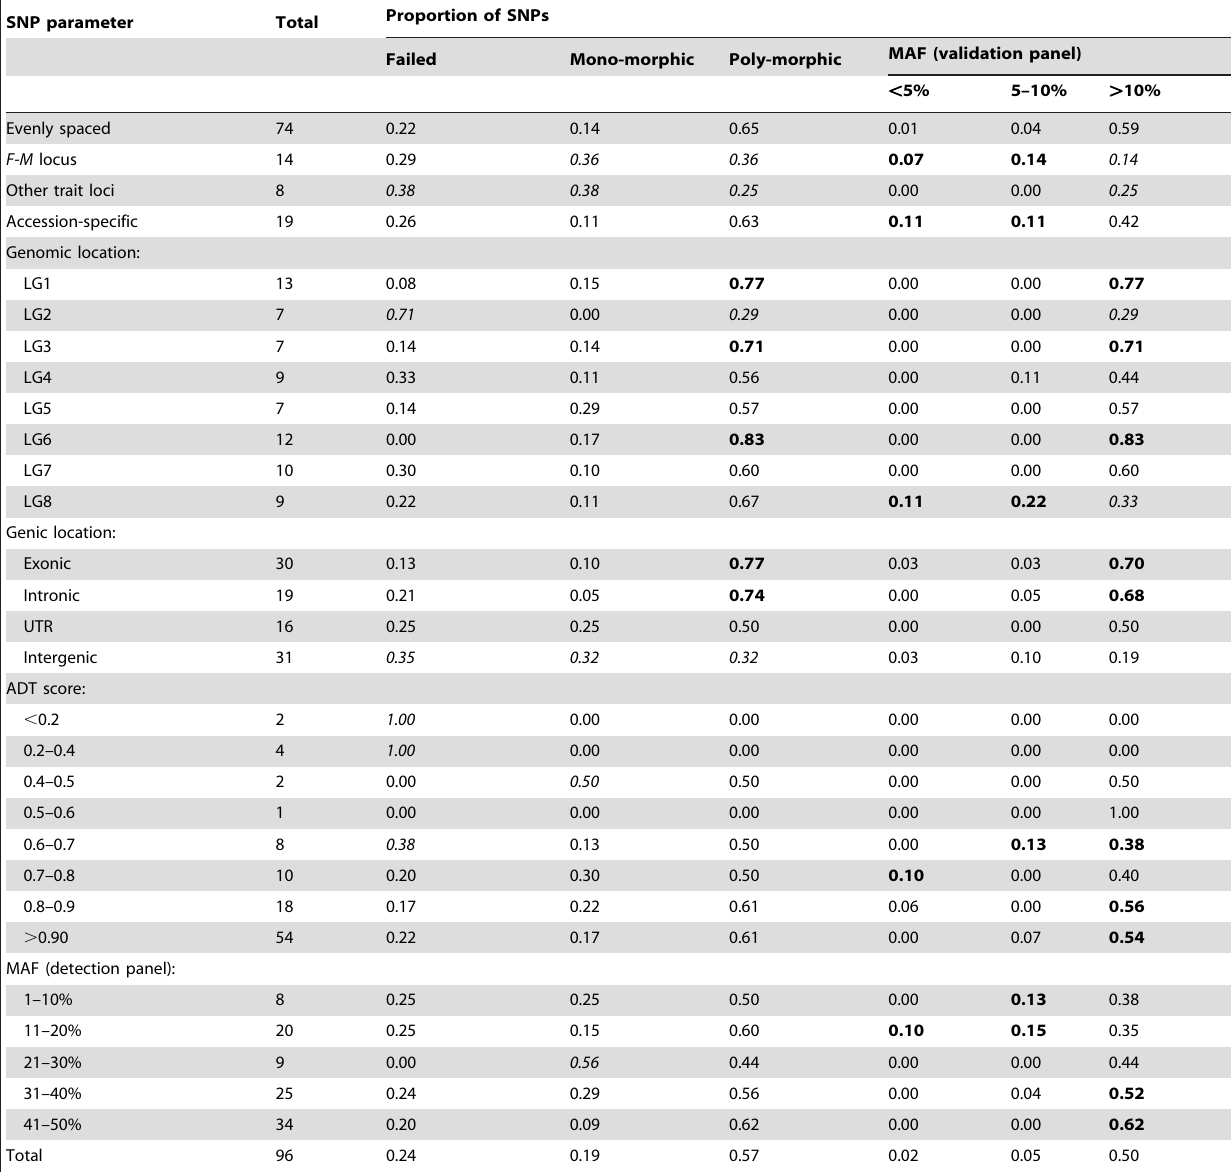
Table 2. Validation outcomes for 96 SNPs with the GoldenGate H